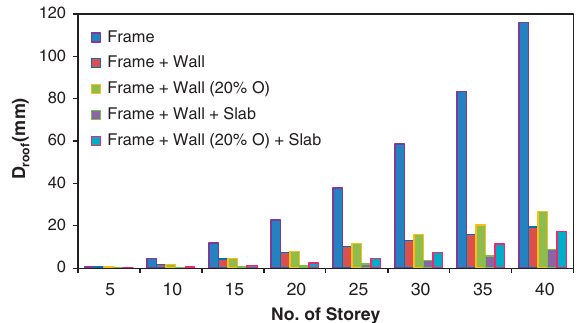
Fig. 3. Effect of wall opening on roof displacement for varying con fi gurations